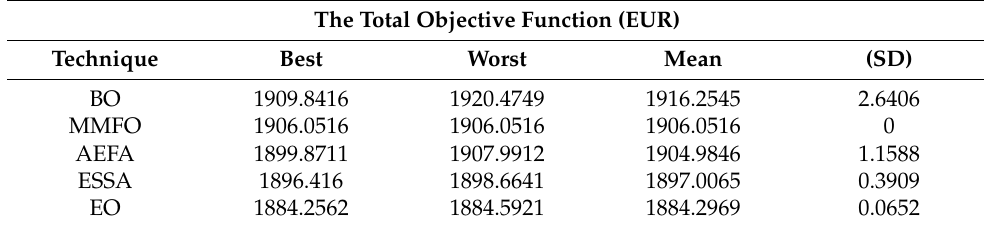
Table 8. Comparison of the statistical results of the objective function in Scenario